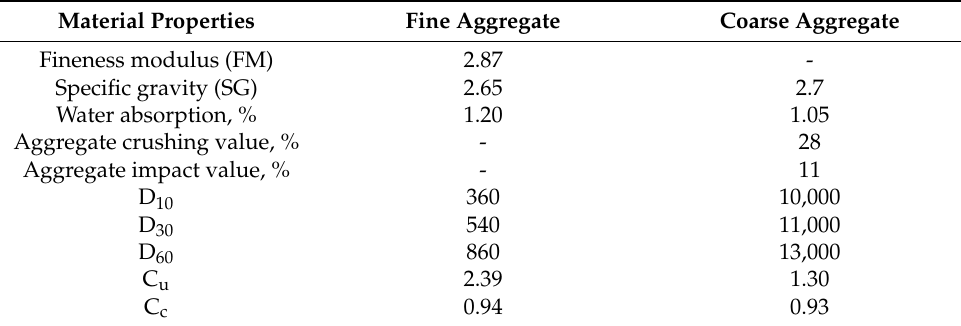
Figure 8. Particle size distribution of aggregates. Table 5. Physical and mechanical properties of aggregates. (Nduka et al.,